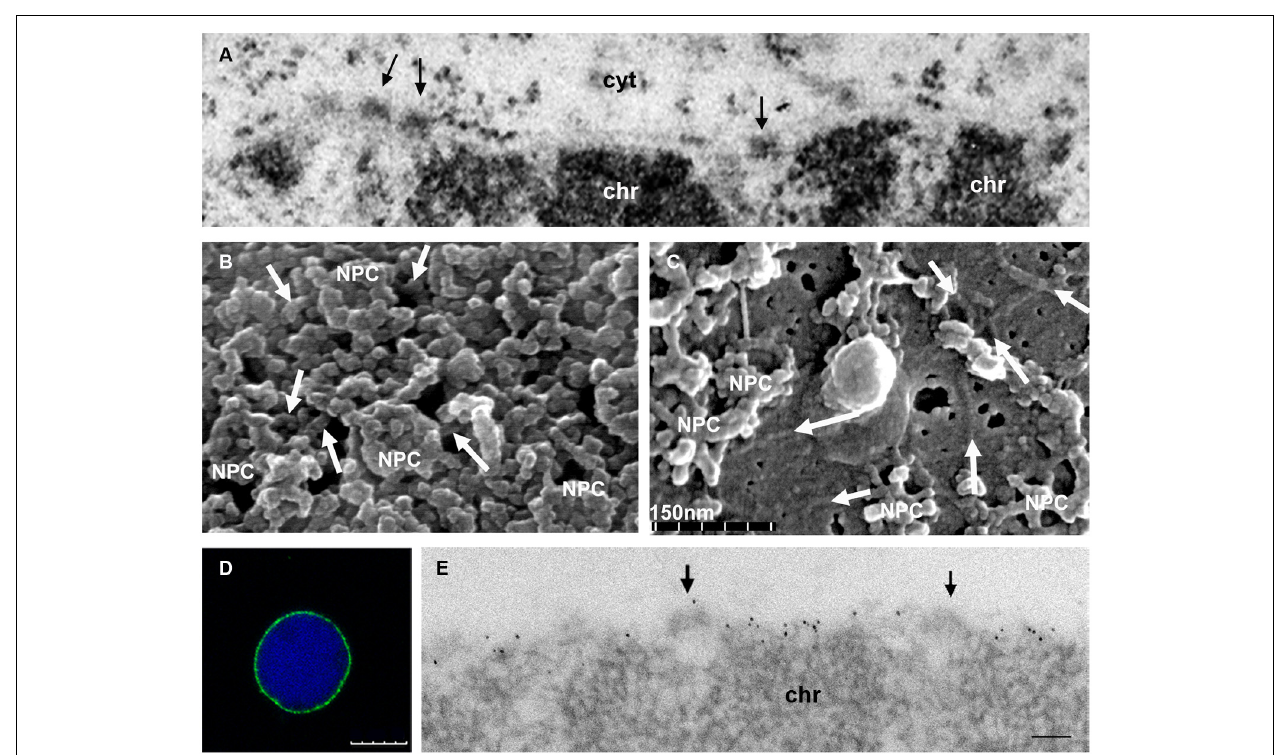
that has been fractured but not extracted with Triton X-100. Arrows indicate the filaments of the lamina in the membrane. (D,E) Detection of NMCP1 in the lamina of isolated meristematic onion nuclei extracted with Triton X-100 after immunofluorescence and DAPI staining (D) , or TEM immunogold labeling (E) . After removing the membrane, the lamina with a lower electron density than chromatin and containing NMCP1 proteins is evident at the nuclear periphery. The association with NPCs (arrows) and the tight attachment to the condensed chromatin masses (chr) can be seen. ( B,C courtesy of Drs J. Fiserova and M. W. Goldberg). Bars in D = 10 μ m and in E = 100